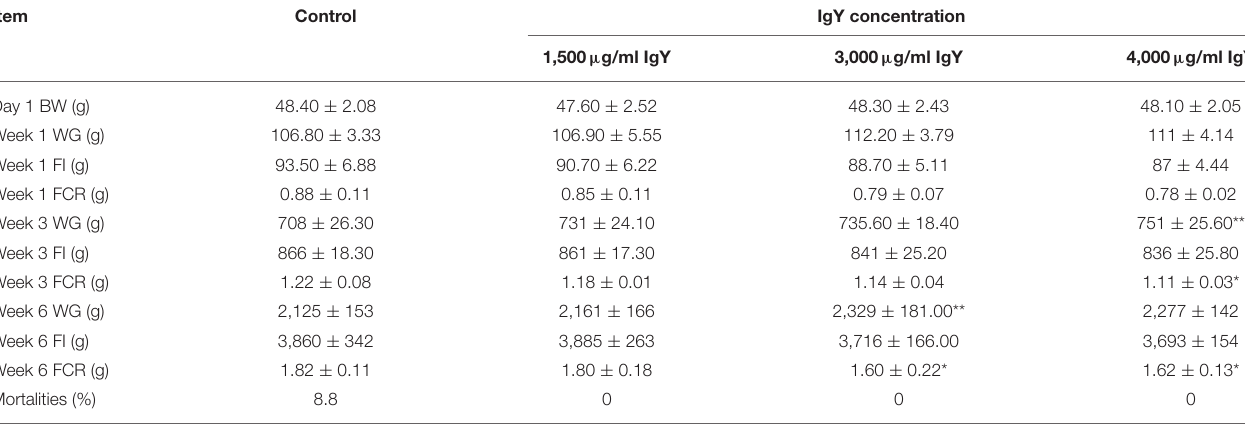
TABLE 4 | Growing rates in the experimental groups fed different IgY concentrations.